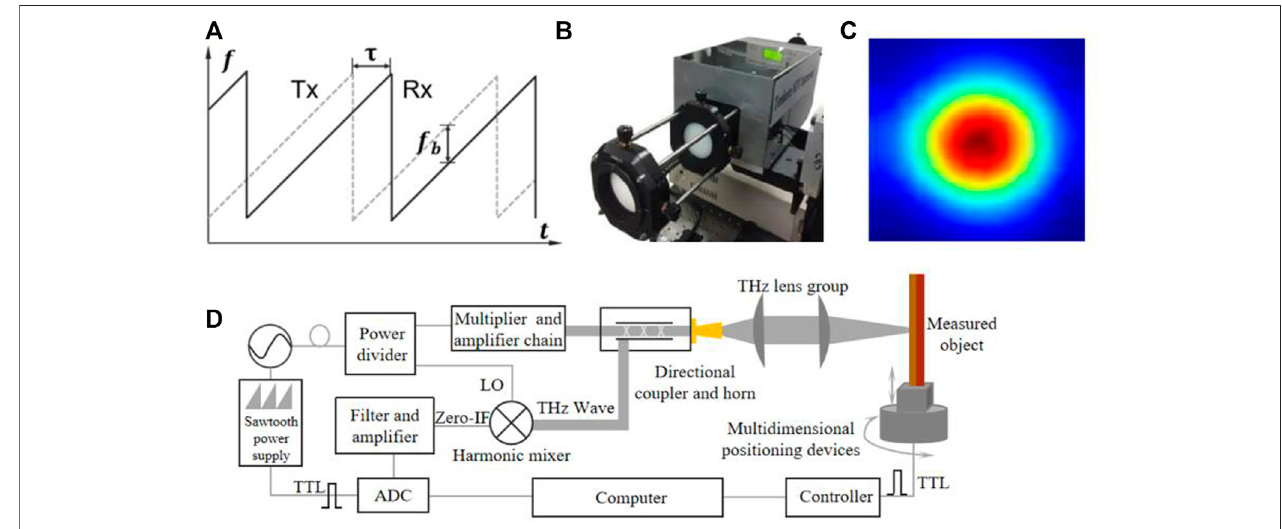
FIGURE 1 | (A) Functional diagram of the system; (B) Physical view of the system; (C) Intensity distribution of the THz wave focus plane; and (D) System architecture.